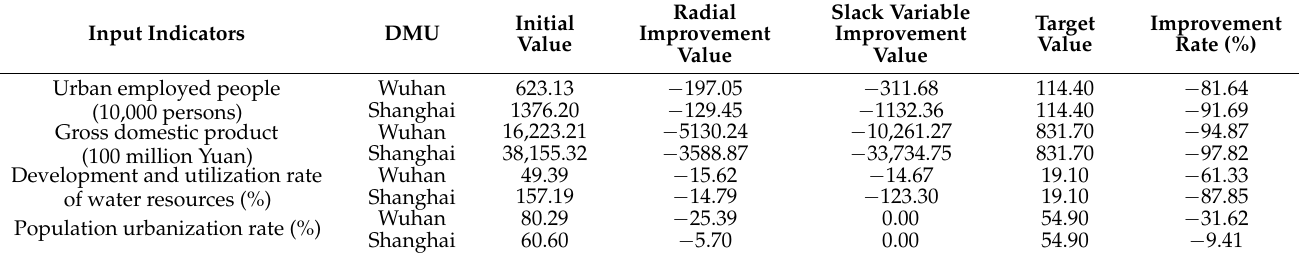
Table 4. Input redundancy and target value of invalid DEA